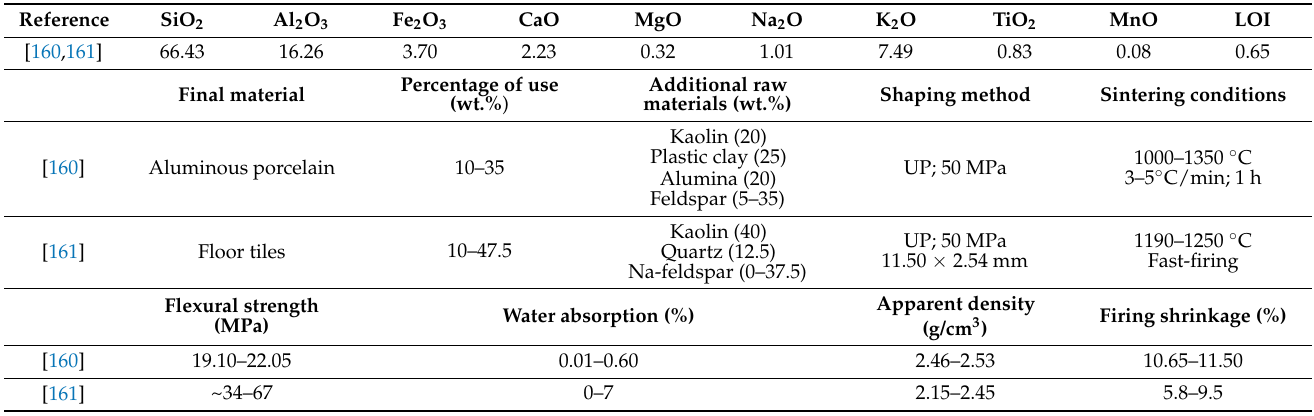
Table 29. Chemical composition (expressed wt.% oxide), processing parameters and technological properties of ceramic materials developed from ornamental rock-cutting